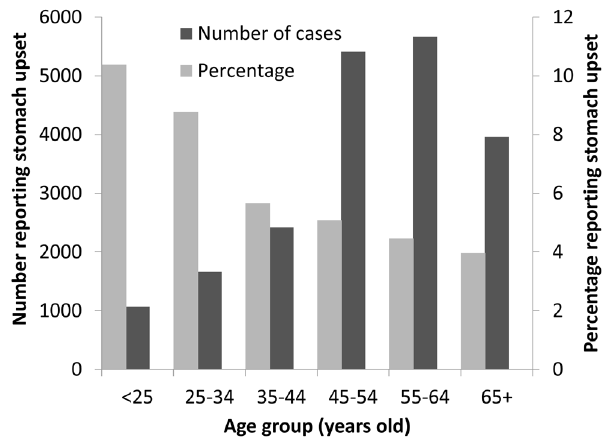
Figure 4. Seasonal distribution of prevalence of reported stomach upset in cruise passengers on cruises departing Spain and Egypt. S=Summer and W=Winter.